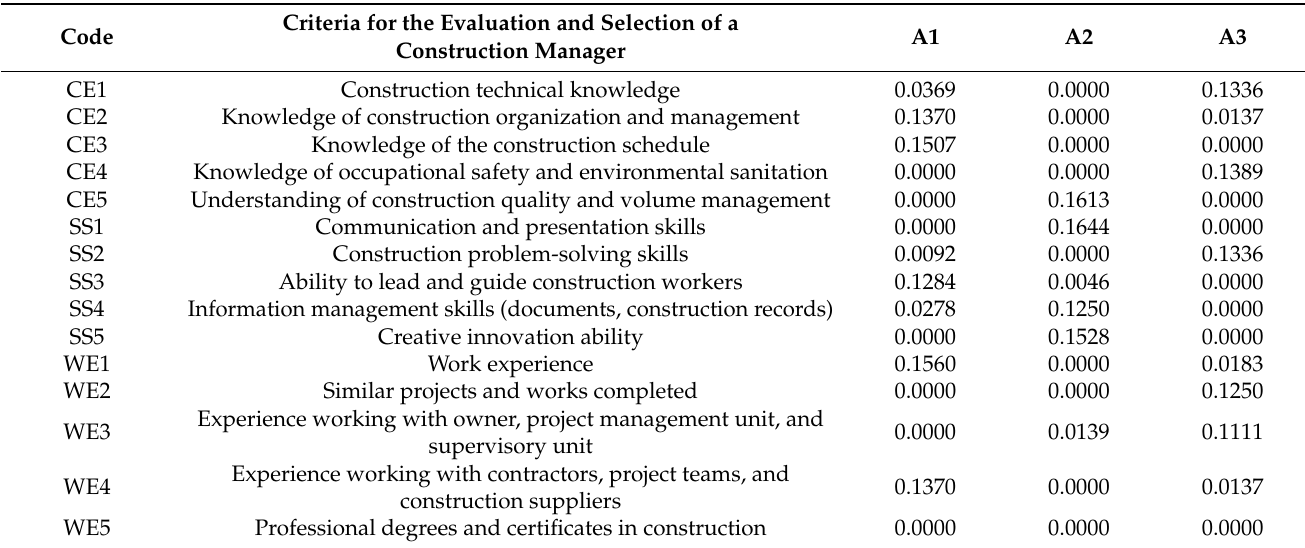
Table 4. Values of the positive distances from the average